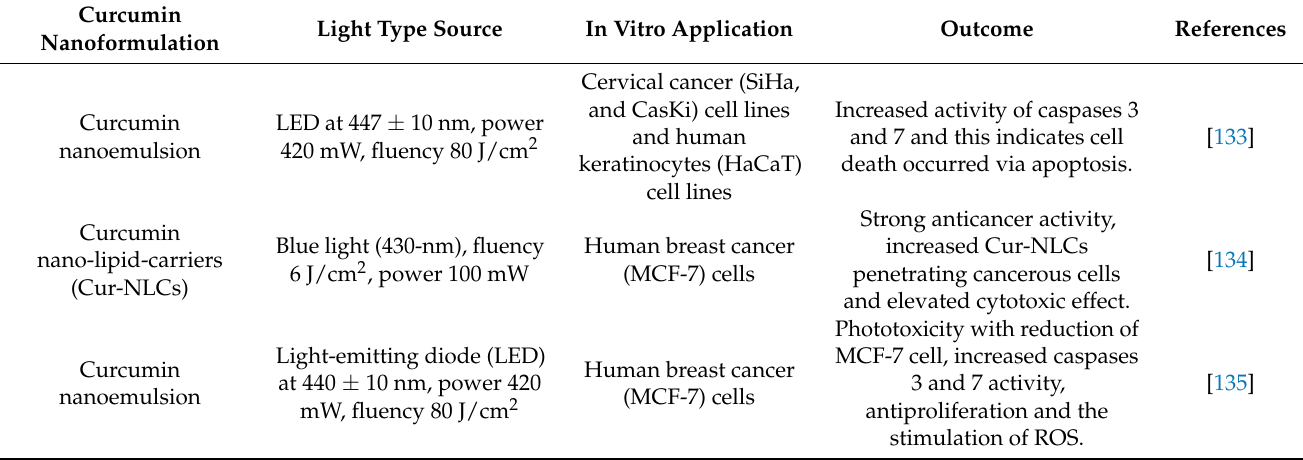
Table 2. Some recent research outcome of nanocurcumins in cancer